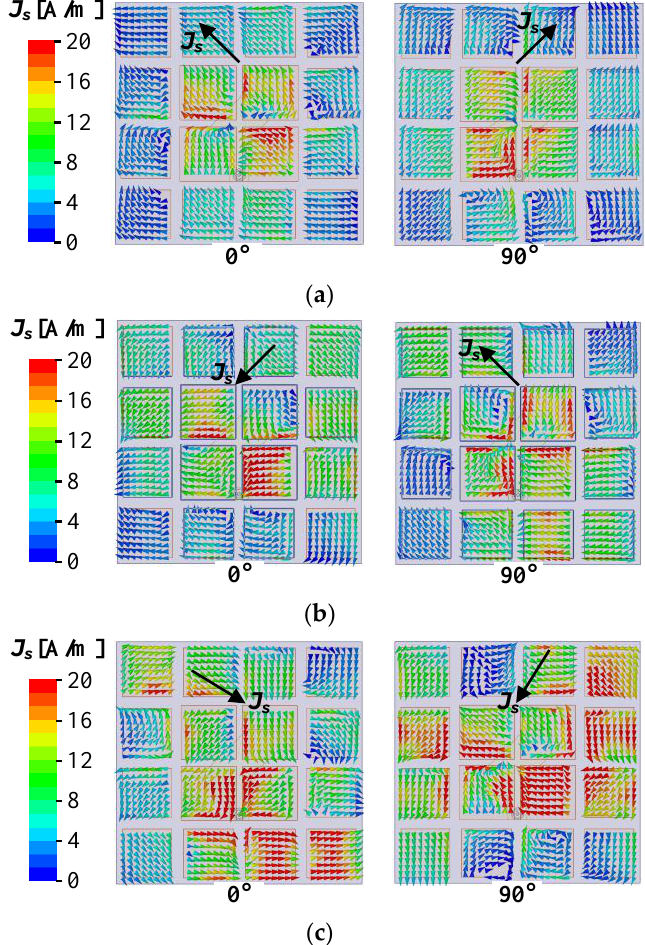
Figure 7. Simulated surface current distributions at ( a ) 5.2 GHz, ( b ) 6.2 GHz and ( c ) 6.9 GHz for the antenna with a non-uniform MS.